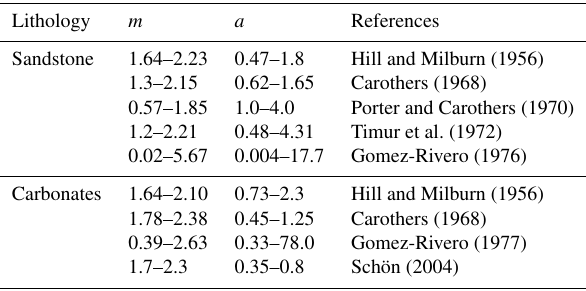
Table 1. Typical ranges of cementation exponent and the a param- eter from the literature (Worthington,